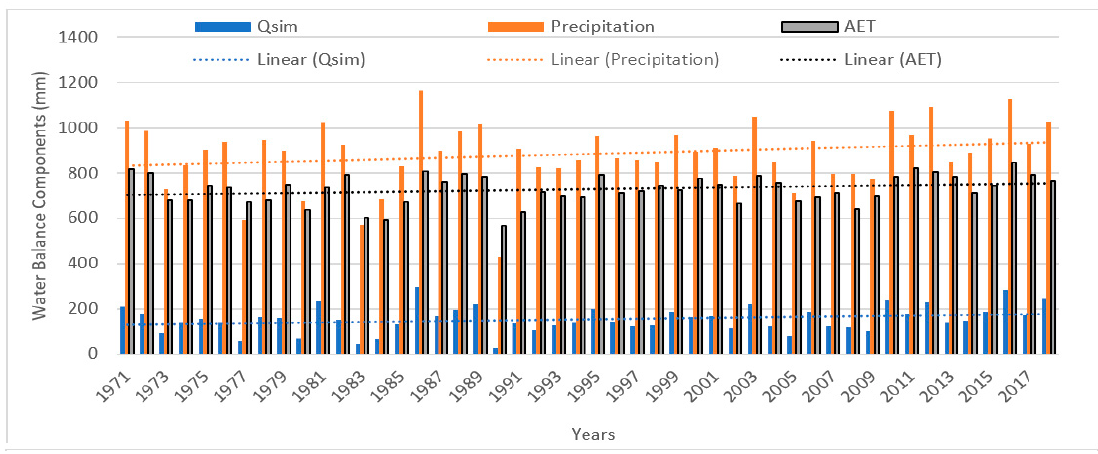
Figure 7. Water balance components: precipitation, simulated discharge (Qsim), and actual evapotranspiration (AET) for the period 1971–2018. Table 2. Sen slope (SS) and total 10-day water discharges (see Section 3.3) in di ff erent conditions for 1971–2018. * indicates a significant trend obtained through the Mann-Kendall